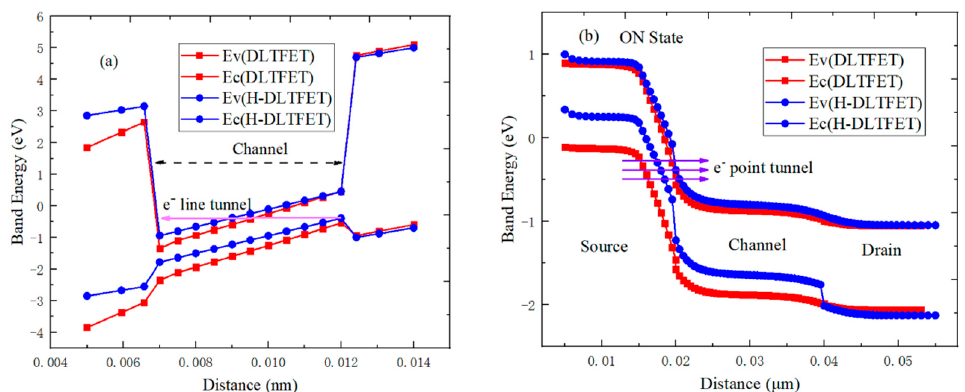
Figure 5. Schematic diagram of the energy band according to the on-state condition ( a ) in the middle of the channel from the top channel to the bottom channel and ( b ) on the channel surface from the source to the drain.